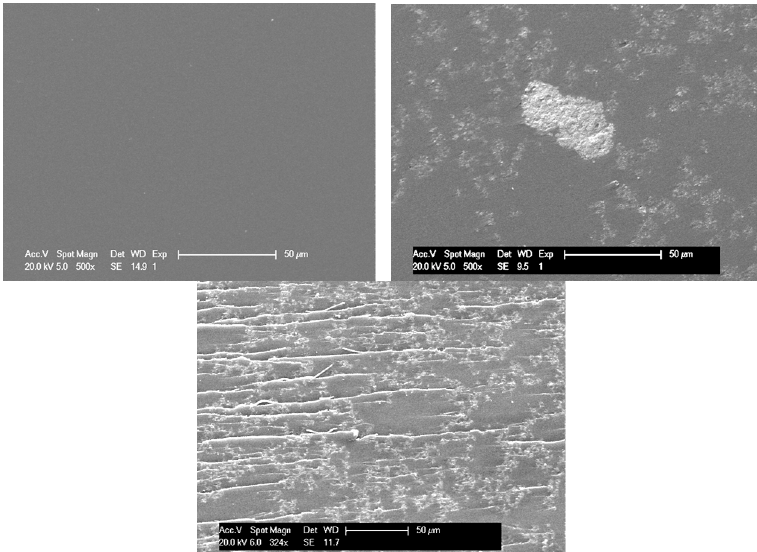
Figure 4. SEM micrograph of unfilled epoxy network ( left ), epoxy/diaminodiphenylsulfone (DDS)/MWNT nanocomposite (0.7 wt %) after a 5 h dispersion with Rayneri ( right ) and epoxy/DDS/MWNT nanocomposite (0.7 wt %) after a dispersion with 3 roll-mill calander ( below ).